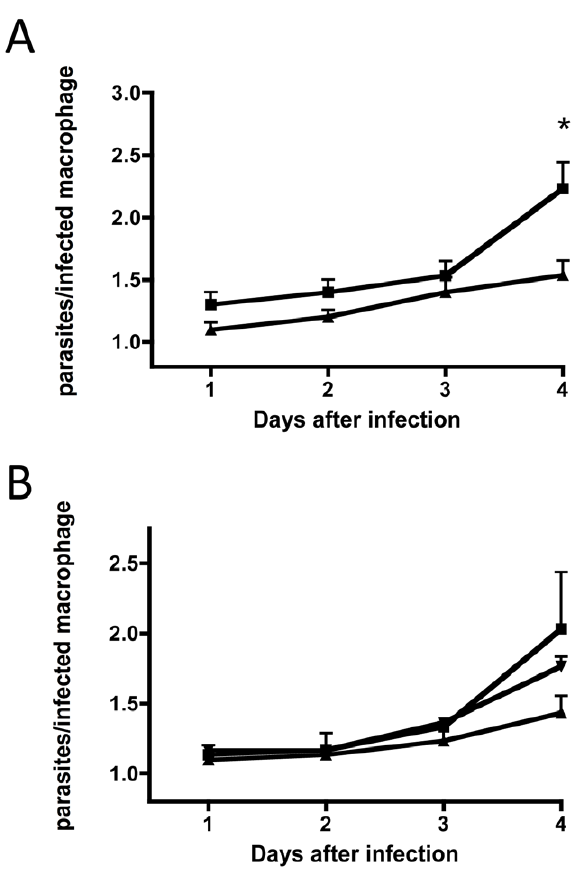
Figure 5. Infection of RAW 264.7 murine macrophages with L. major promastigotes. Data is presented as the number of parasites per infected macrophage, as observed by microscopy. Error bars represent S.E.M. from three independent experiments performed in triplicate. A. Macrophages infected with L. major wild type (squares) or L. major D msrA (triangles). A significant decrease in parasite numbers is observed at day 4 for L. major D msrA ( P= 0.01, unpaired t-test). B. Macrophages infected with L. major + pXG1A (squares), L. major D msrA + pXG1A (triangles) or L. major D msrA + pXG1A- msrA (inverted